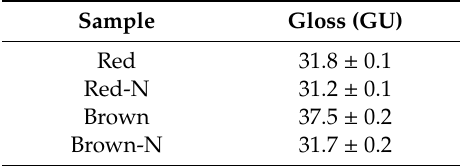
Table 5. Initial state gloss measurements at 60° for all the samples.